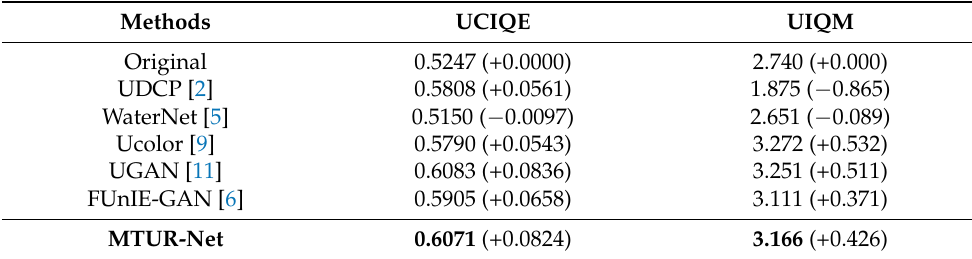
Table 3. UCIQE [27] Scores and UIQM [28] Scores of Different Methods on